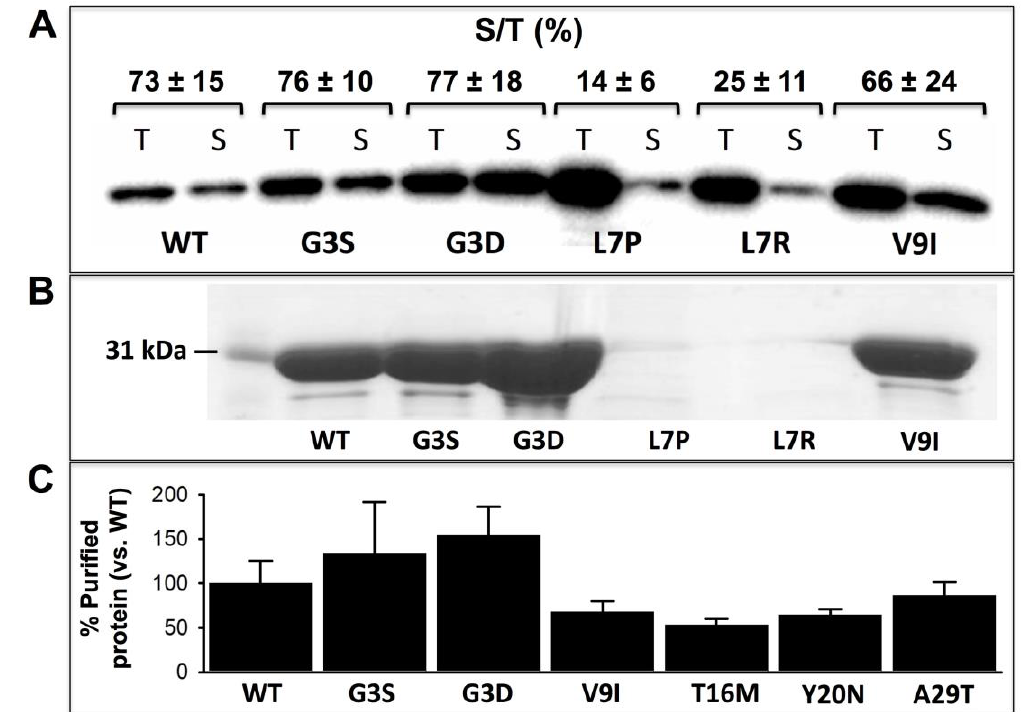
Figure 2. Expression and solubility of NQO1 variants in E. coli cells. ( A ) Western-blot analysis of NQO1 content upon expression in E. coli cells. Cells were sonicated to obtain total extracts (T), while soluble extracts (S) were obtained upon centrifugation at 21,000 × g for 20 min at 4 ◦ C. Samples were denatured with Laemmli bu ff er and submitted for Western-blot analysis using anti-NQO1 antibody, F-8 antibody (Santa Cruz Biotechnology). The Western-blot is representative from three di ff erent purifications. The fraction of the total protein found in the soluble extract upon densitometric analysis (S / T, as %) is indicated (as mean ± s.d. from three independent experiments). ( B ) Purified NQO1 proteins from three di ff erent purifications were concentrated ~10-fold and samples analyzed by SDS-PAGE. Note that during purification and storage, the remaining soluble protein of L7P and L7R was negligible. ( C ) Yield in NQO1 protein variants after immobilized-metal a ffi nity chromatography (IMAC) purification. Data were the mean ± s.d. from 3–4 di ff erent purifications for each NQO1 variant. Wild-type (WT) levels were 1.45 ± 0.38 mg · L − 1 of culture and used to normalize yields.